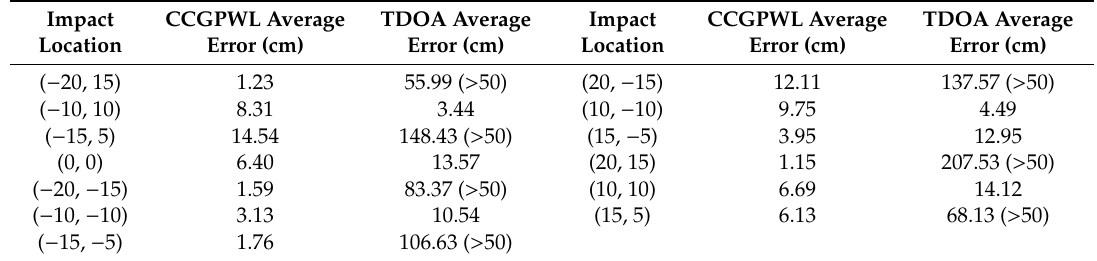
Table 4. Comparison between the CCGPL algorithm and the time difference of arrival (TDOA) method.